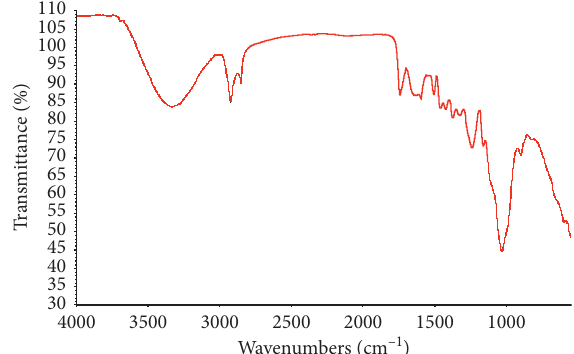
Figure 2: FTIR wavenumbers for untreated Marula nutshell.